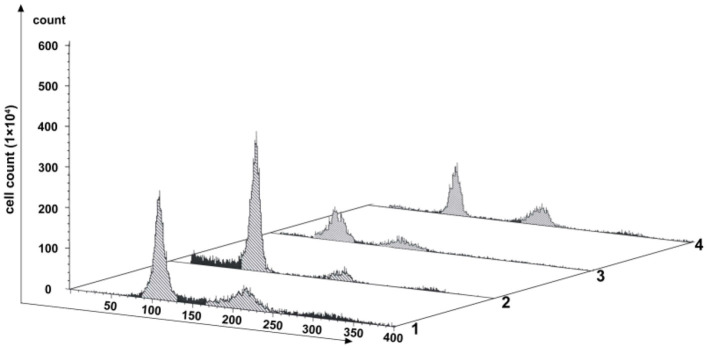
Effects of PFT-α on SP600125-treated cells. Flow cytometry analysis of the proliferation variation of cells. Lane 1 represents the control group (cultured without SP600125). Lane 2 stands for the PFT-α group (cells pretreated by PFT-α for 24 h. Lane 3 shows the cells first being cultured with PFT-α-free medium for 12 h and then being further treated by SP600125 for 48 h. Lane 4 shows the cells which the obtained cells in Lane 3 were further cultured in SP600125-free medium for another 12 h.